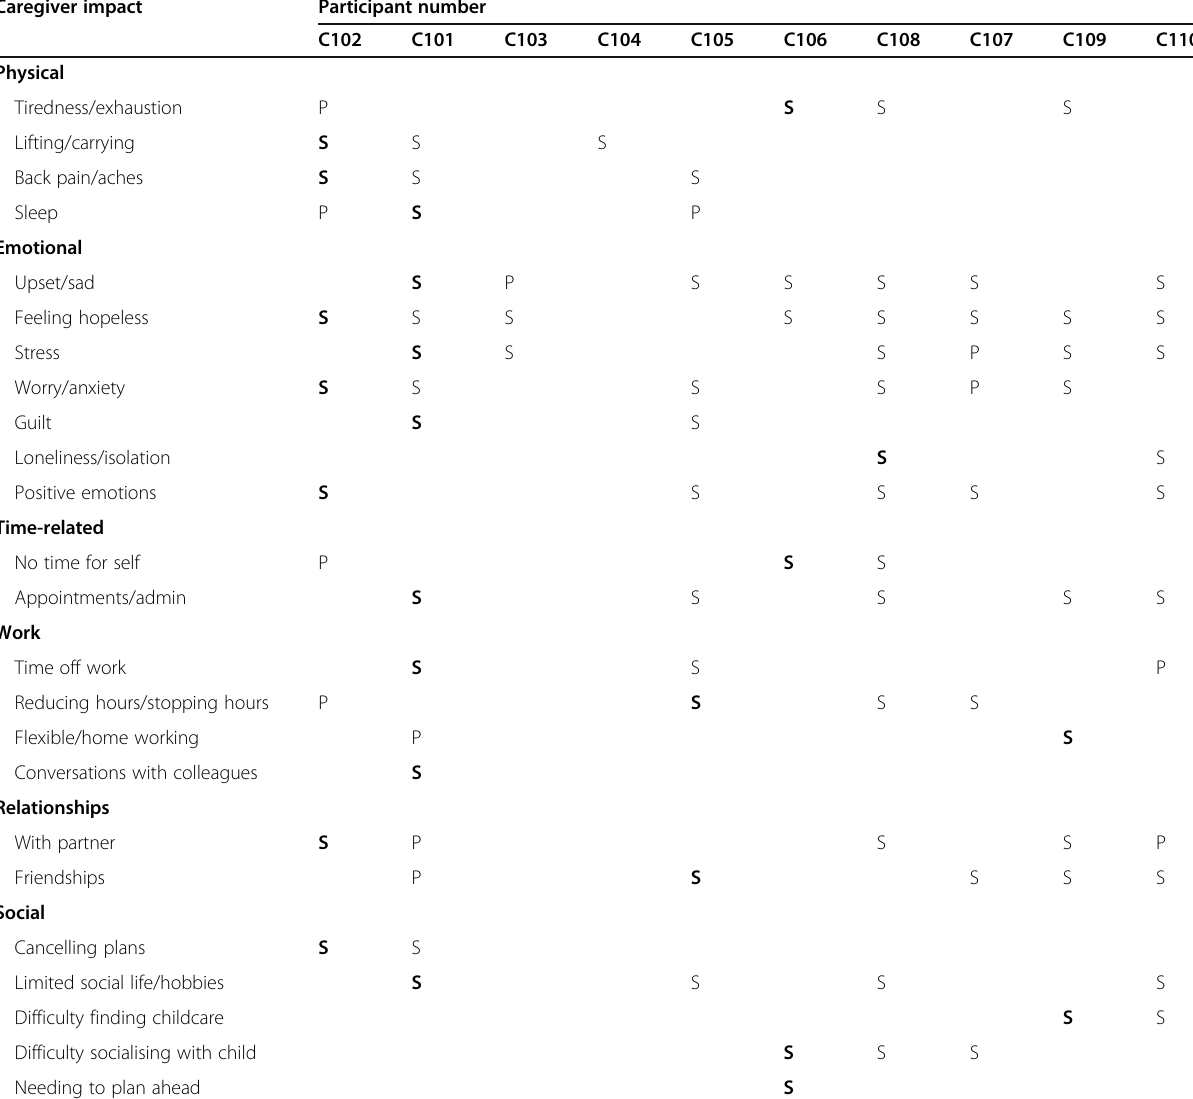
Table 2 Data saturation